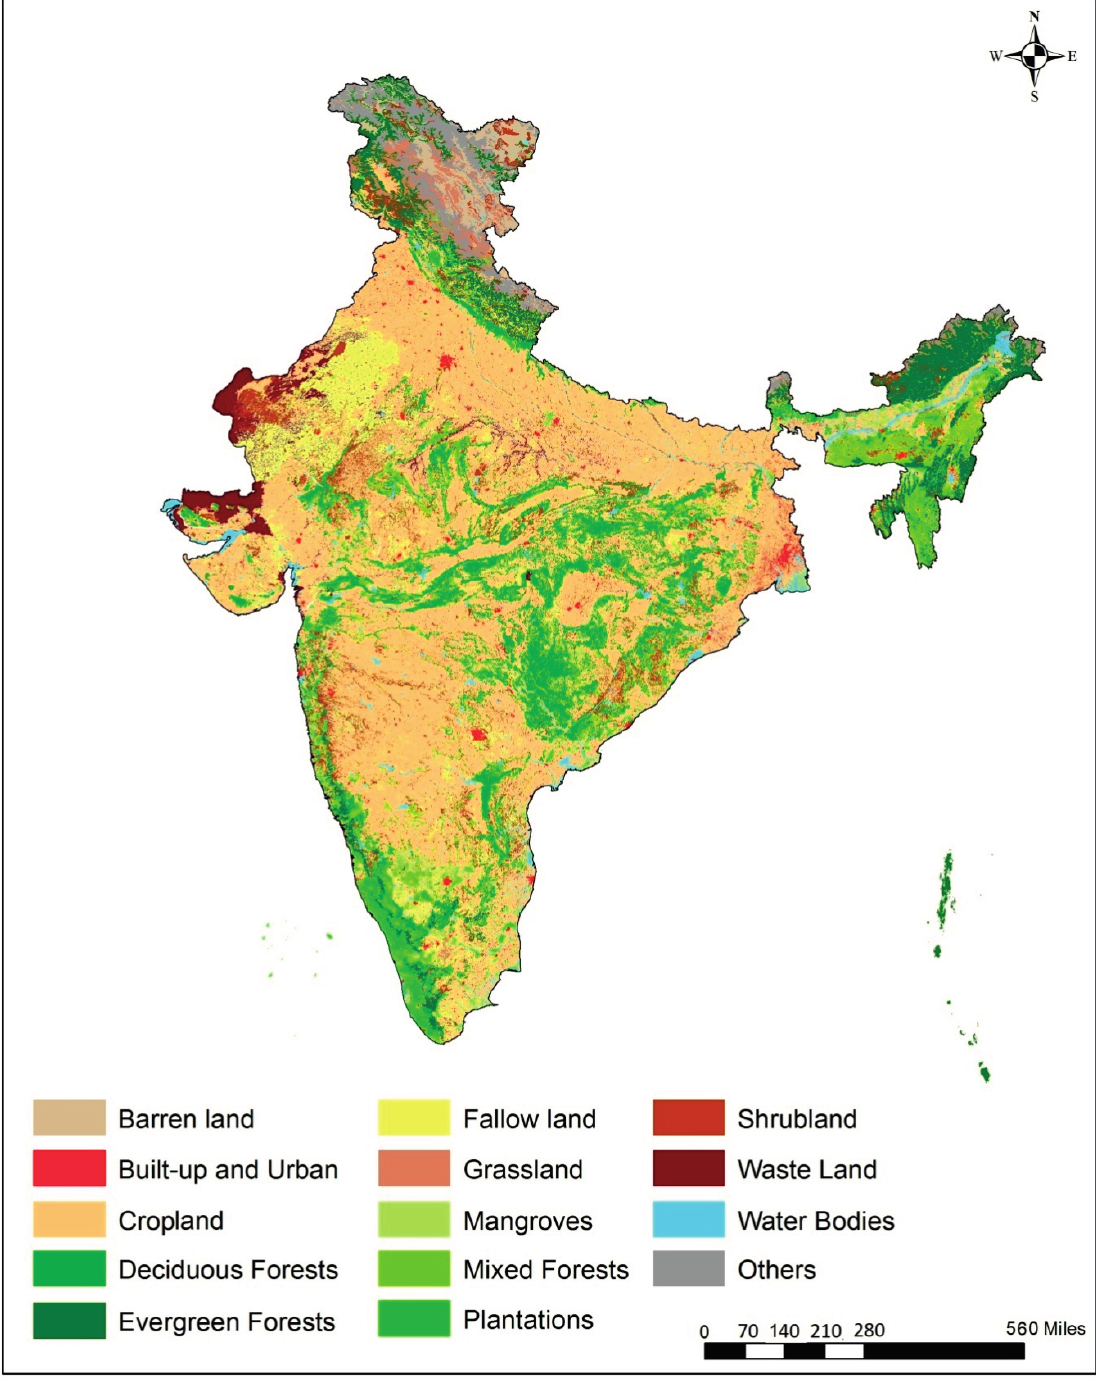
Figure 2. Land use and land cover map of India for 2005. This map serves as a reference for 1995 and 1985 LULC maps (shown in